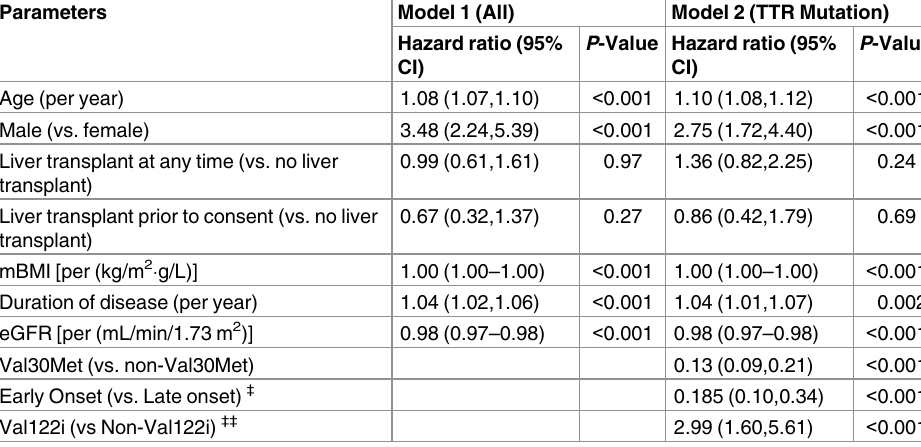
Table 4. Potential risk factors of survival by univariate